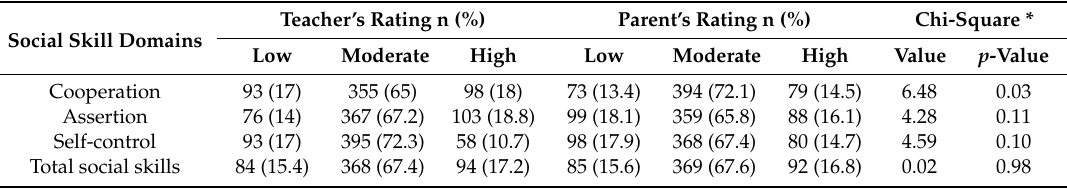
Table 3. The social skills of preschool children from the teachers’ and parents’ perspectives and related di ff erences (n = 546).